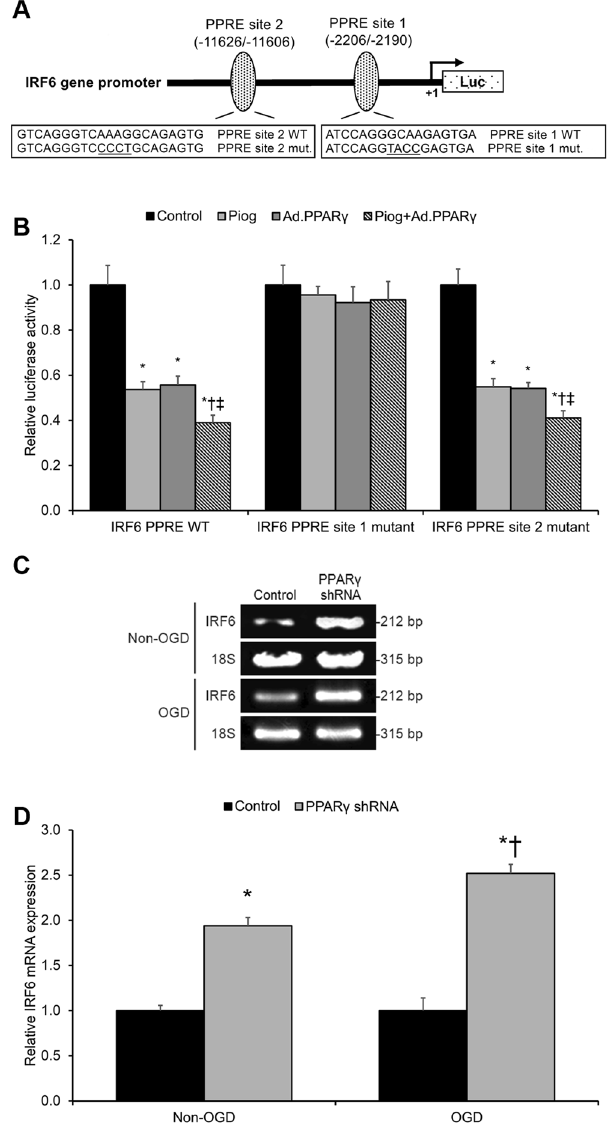
Figure 2. PPAR γ Trans-Represses IRF6 in Cerebrovascular Endothelial Cells. ( A ) Diagram of the pGL 4.10 luciferase reporter plasmid carrying the murine IRF6 gene promoter sequence 5 ′ -upstream of Luc. Two putative PPRE binding sites were identified at − 2206/ − 2190 bp (PPRE site 1) and − 11626/ − 11606 bp (PPRE site 2). Transcription starts at + 1 bp. ( B ) A luciferase reporter assay was conducted by transfecting murine cerebrovascular endothelial cells with the pGL 4.10 luciferase reporter plasmid delivering either the IRF6 wild- type promoter sequence (IRF6 PPRE WT) or the IRF6 promoter sequence carrying a mutation at one of the two PPRE sites (IRF6 PPRE site 1 mutant or IRF6 PPRE site 2 mutant). Pioglitazone and/or PPAR γ gain-of-function significantly elevated IRF6 wild-type promoter activity but did not affect IRF6 PPRE site 1 mutant promoter activity. * P < 0.05 versus control group, † P < 0.05 versus Pioglitazone group, ‡ P < 0.05 versus Ad.PPAR γ group. ( C,D ) Real-time PCR on the total RNA content from control and small-hairpin PPAR γ RNA (PPAR γ shRNA)- transfected murine cerebrovascular endothelial cells revealed that PPAR γ silencing significantly elevates IRF6 mRNA expression, particularly more significantly under oxygen-glucose deprivation (OGD) conditions. Cropped blots are displayed here. * P < 0.05 versus same-condition Control group, † P < 0.05 versus Non-OGD PPAR γ shRNA group. Data are reported as means ± standard errors of the mean